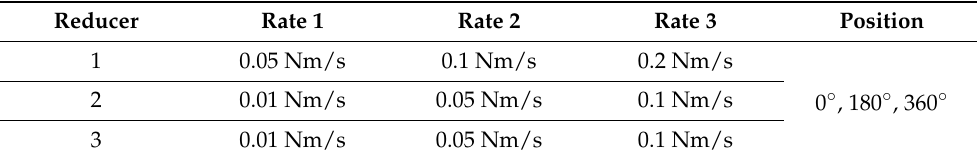
Table 3. Experiment conditions.